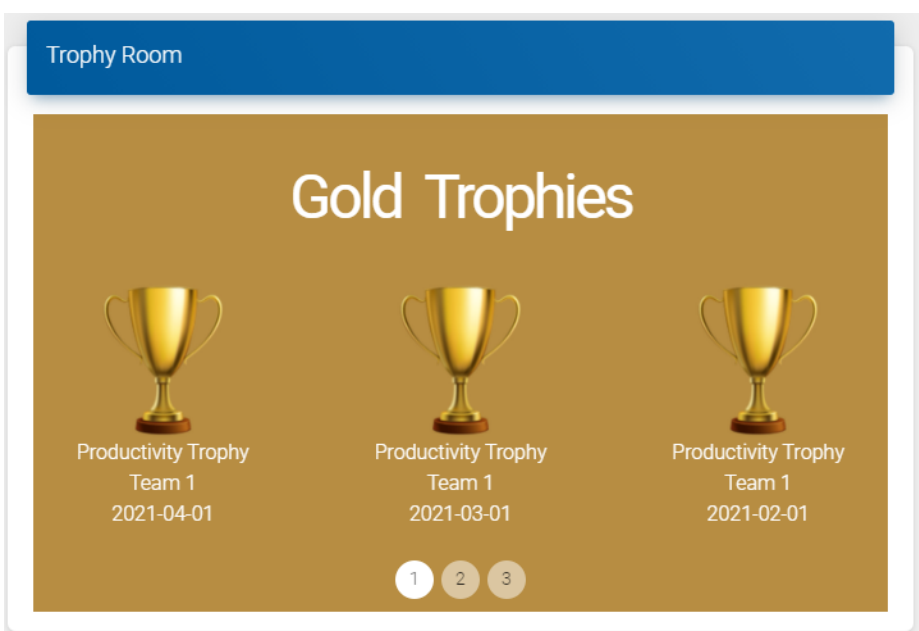
Figure 9. Trophies